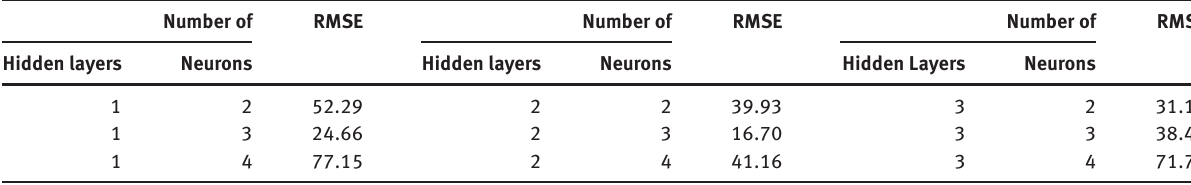
Table 1 Result of utilizing different numbers of hidden layers and neuron. Number of RMSE Number of Number of Hidden layers